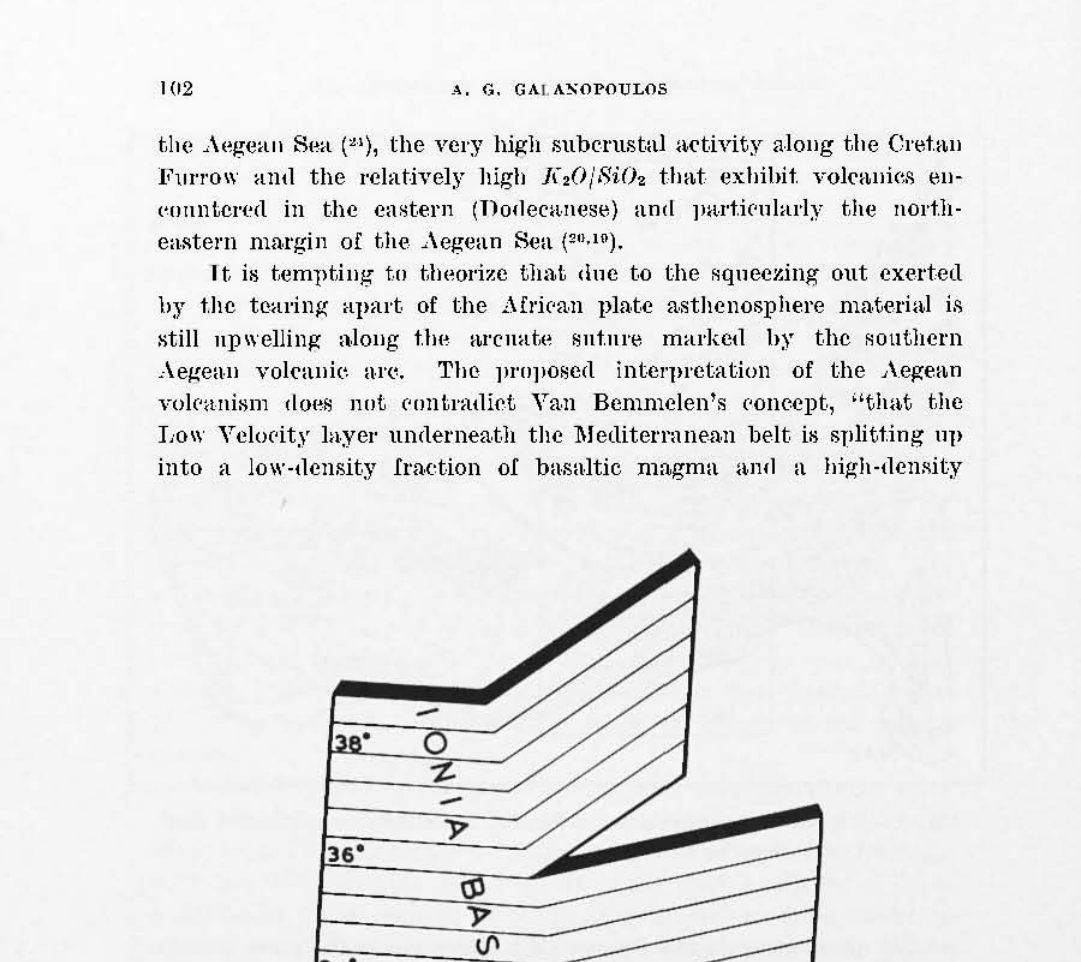
- Fig, 9 - l'o~t.IlIJltcd plutl" tcetonic6 in thc Ill'cn or Orcccc. erystalline resillue"